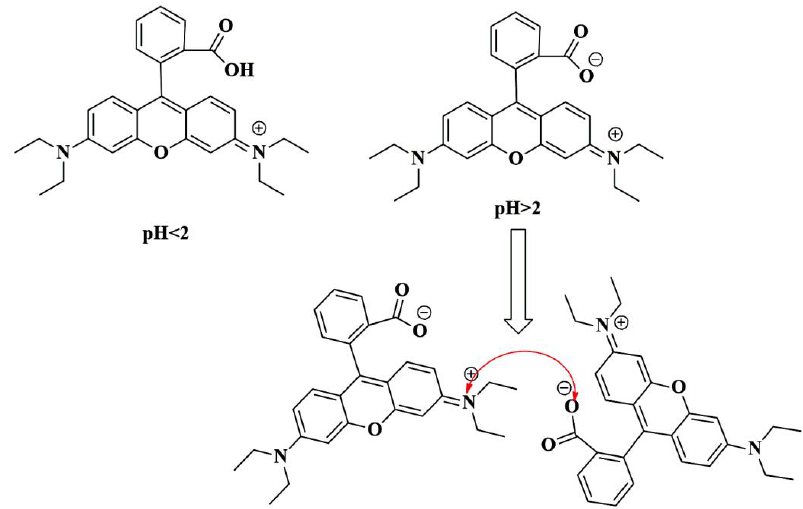
Scheme 2. Rh B molecule in different Scheme 2 Rh B molecule in different pH